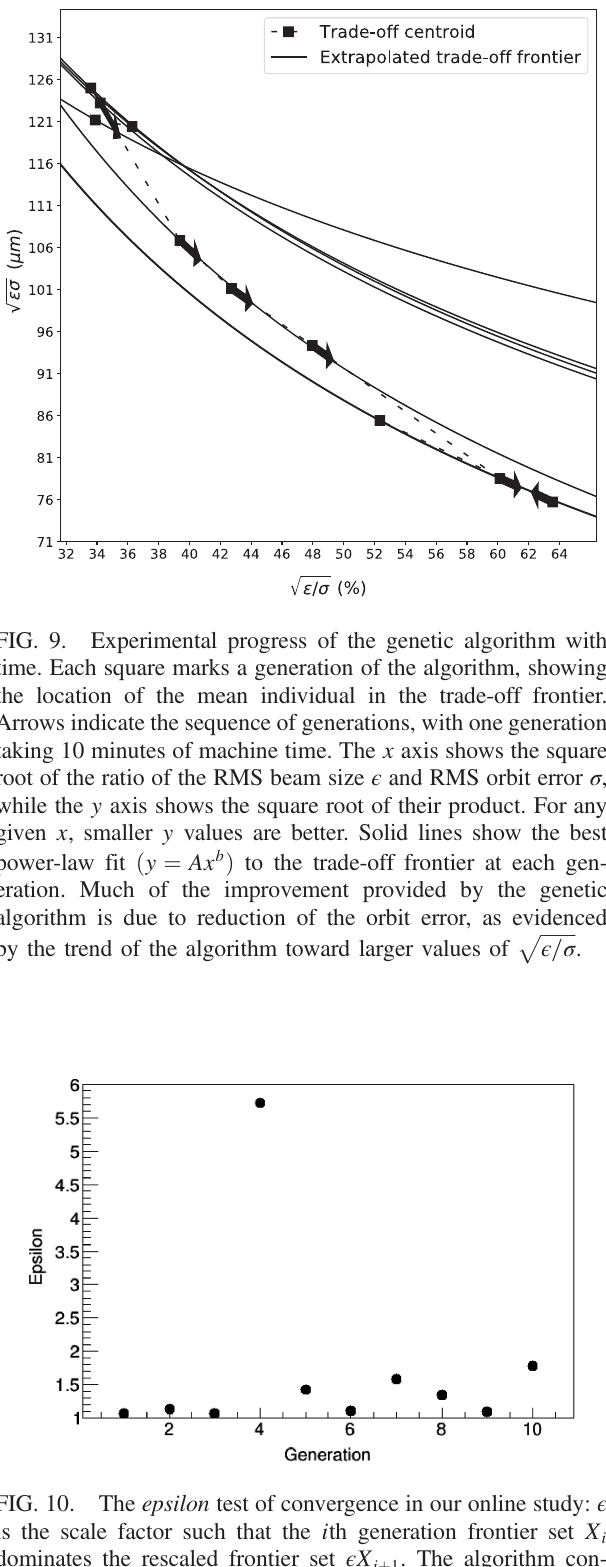
FIG. 10. The epsilon test of convergence in our online study: ϵ is the scale factor such that the i th generation frontier set X i dominates the rescaled frontier set ϵ X i þ 1 . The algorithm con- verges as ϵ approaches unity. The figure shows that the algorithm is still providing improvement at the end of the allotted time. Comparison with Fig. 9 shows that this improvement is mainly due to reduction in the orbit